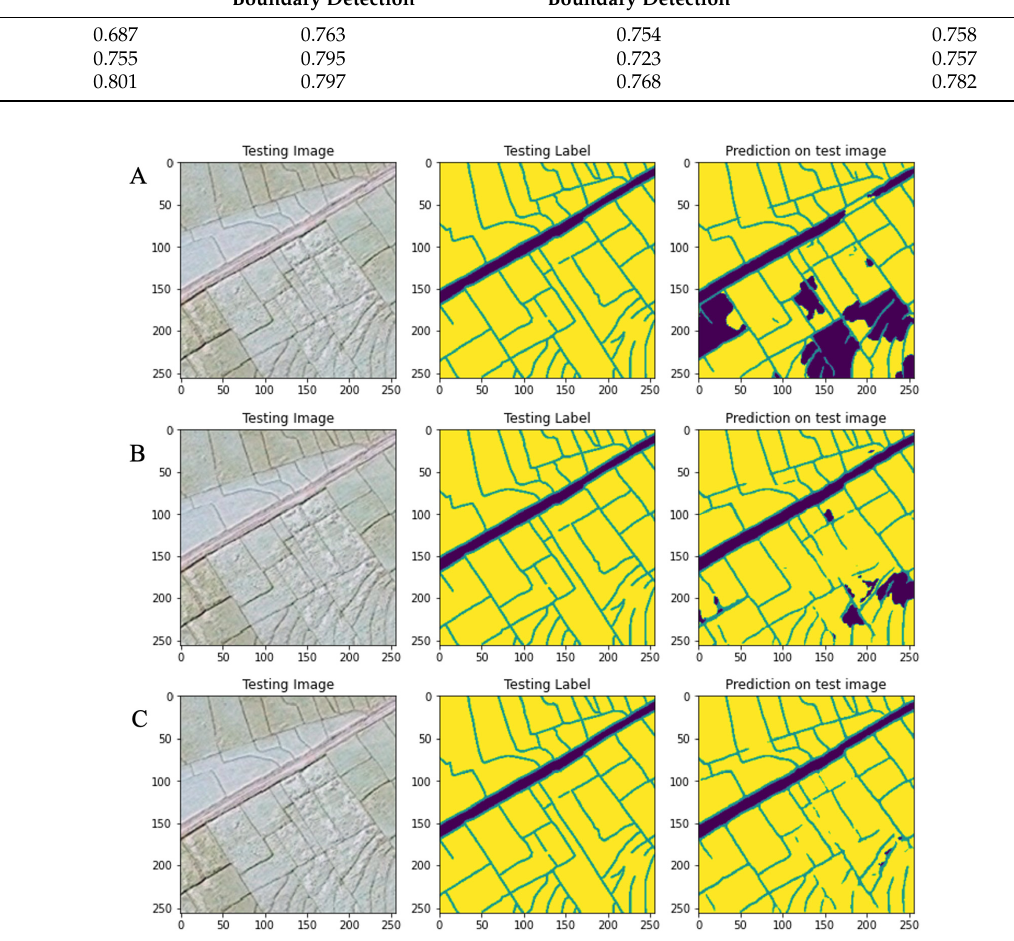
Figure 7. Field boundary detection results on a test image by the simple U-net ( A ), ResNet34-based U-net ( B ), and SeresNet34-based U-net ( C ). Yellow area denotes agricultural field, blue area denotes background land cover, and green area denotes field boundary.